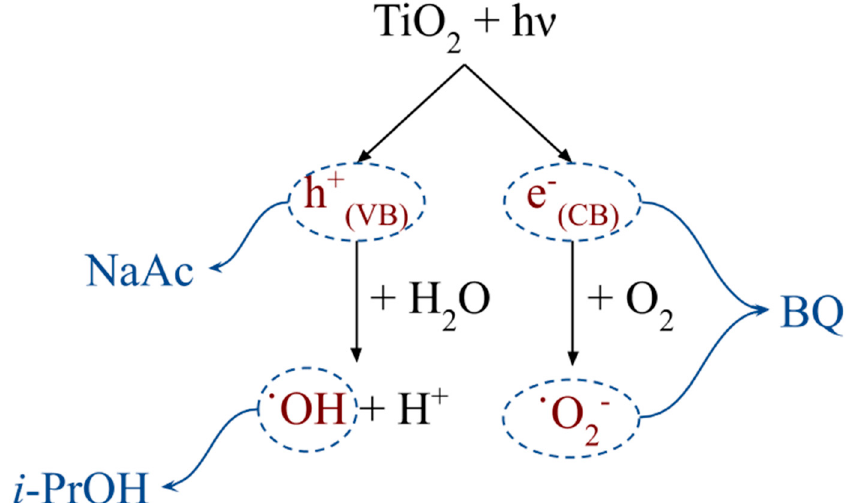
Scheme 2. Process of photo-activation of titania in water. The species responsible for the conversion of HMF are marked in red, while the scavengers used are marked in blue. NaAc: Sodium Acetate; i-PrOH: 2-Propanol; BQ: BenzoQuinone.